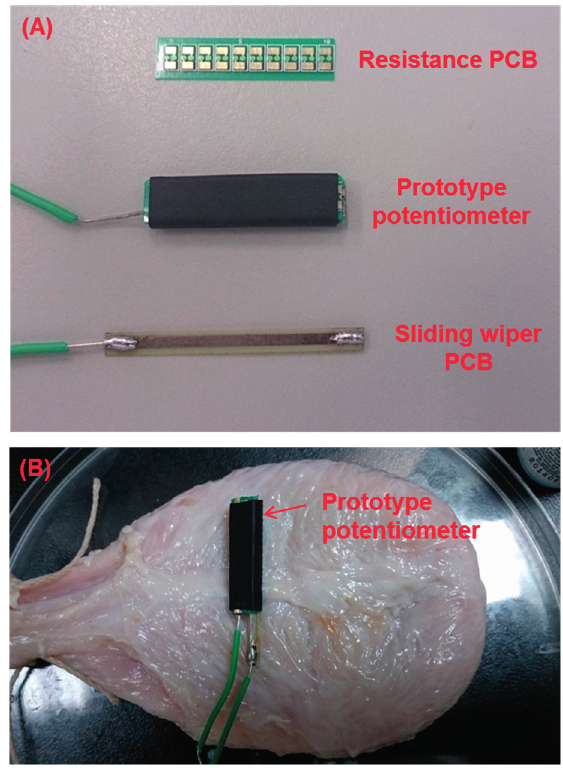
Figure 4. Configuration of the prototype potentiometric module. ( A ) The prototype potentiometric module was fabricated with two fiberglass printed circuit boards (PCBs), including a resistance and a sliding wiper PCB; ( B ) the packaged potentiometer module was fixed onto a fresh pig bladder for volume